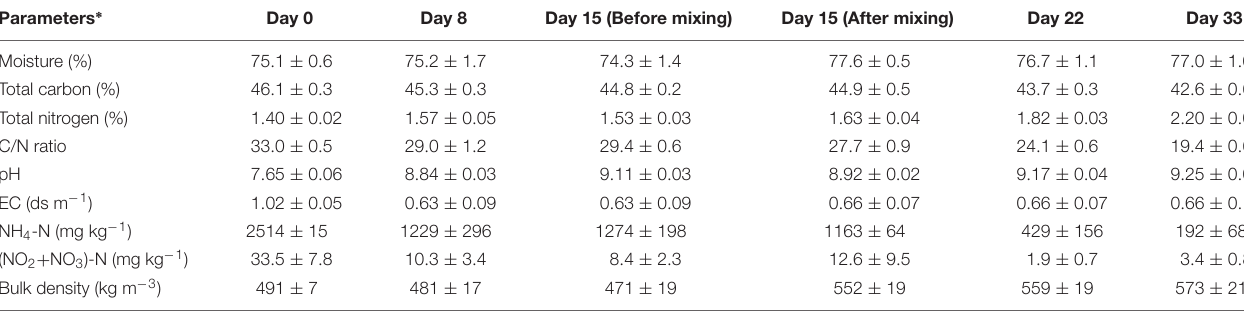
TABLE 2 | Physicochemical changes of compost mixtures during laboratory-scale composting. Parameters